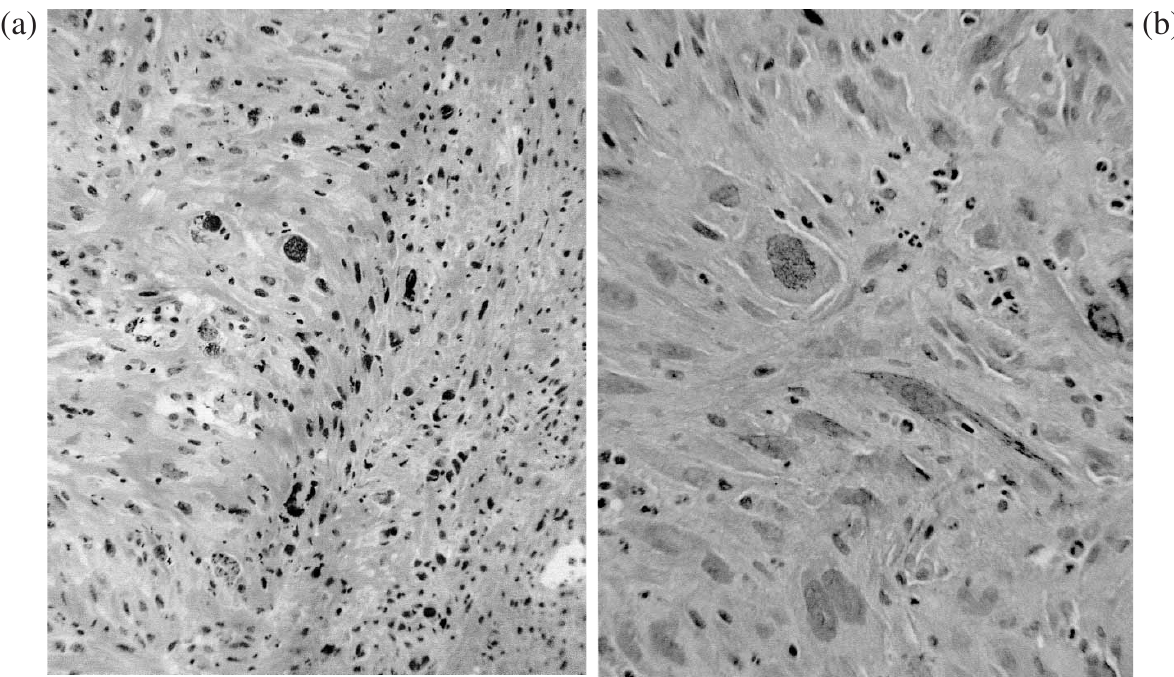
Fig. 4. (a) High power H&E reveals a spindle cell neoplasm with marked nuclear atypia and abnormal mitotic figures. (b) High power SMA stain supports the diagnosis of leiomyosarcoma. Additional stains included vimentin (positive) and keratin